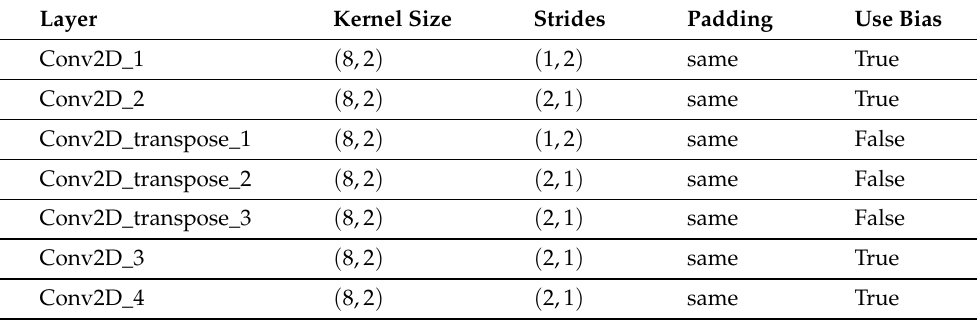
Figure 19. The structure of the discriminator for the Co-Varying Spiral problem. Table 3. Hyperparameters used in the construction of the convolutional neural